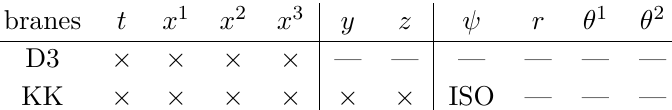
. T-duality along the ψ direction reproduces n